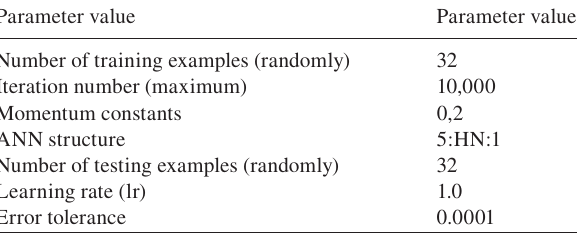
Table 1 The network training parameters.